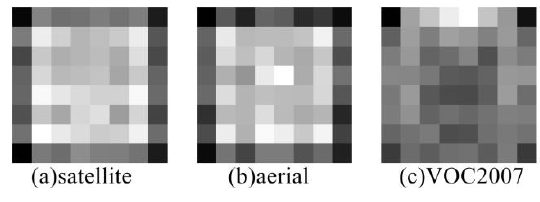
Figure 6. Learned linear model w